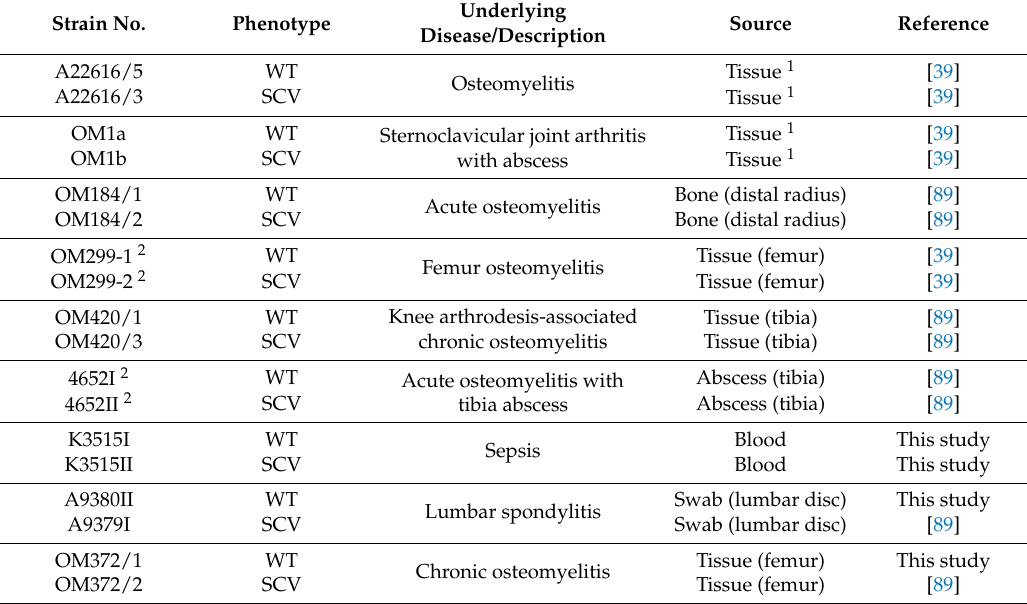
Table 4. Characteristics of methicillin-susceptible S. aureus (MSSA) strains analyzed in this study. Strain